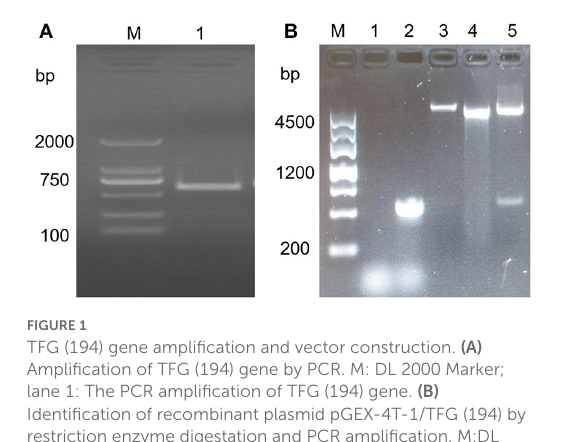
FIGURE1 TFG (194) gene amplification and vector construction. (A) Amplification of TFG (194) gene by PCR. M: DL 2000 Marker; lane 1: The PCR amplification of TFG (194) gene. (B) Identification of recombinant plasmid pGEX-4T-1/TFG (194) by restriction enzyme digestation and PCR amplification. M:DL 4500 Marker; lane 1: Negative control; lane 2: